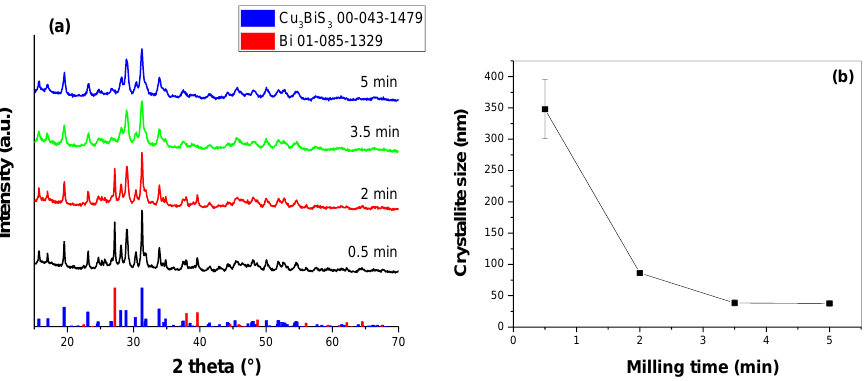
Figure 1. XRD analysis of mechanochemically synthesized wittichenite Cu 3 BiS 3 : ( a ) XRD patterns (milling time and corresponding numbers of PDF cards of the identified crystallographic phases from the JCPDS PDF2 database are provided in the figure); ( b ) Cu 3 BiS 3 crystallite size change with milling time estimated by the Rietveld refinement.